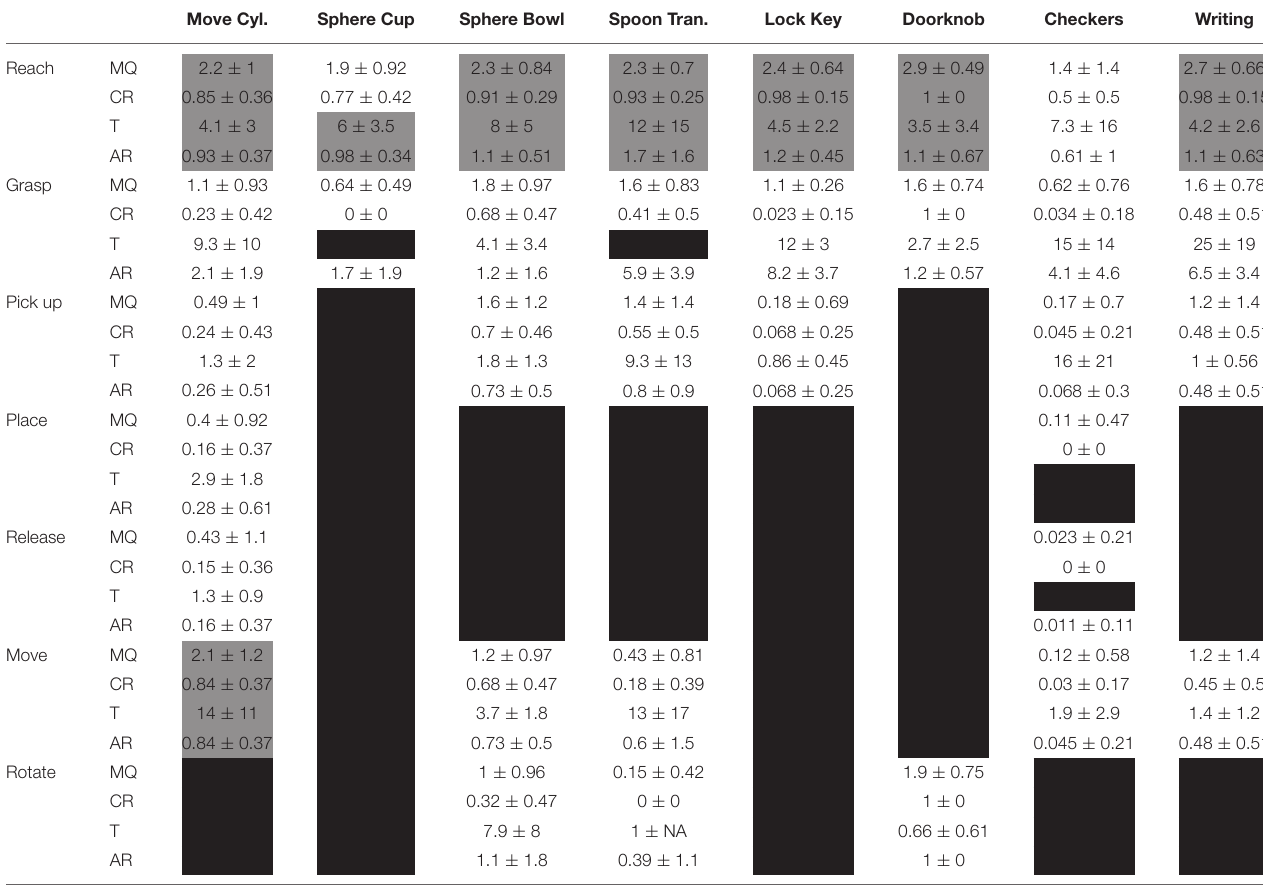
TABLE 5 | Average and standard deviation for VR characteristic values across subtasks and their high-level tasks. Move Cyl. Sphere Cup Sphere Bowl Spoon Tran. Lock Key Doorknob Checkers Writing